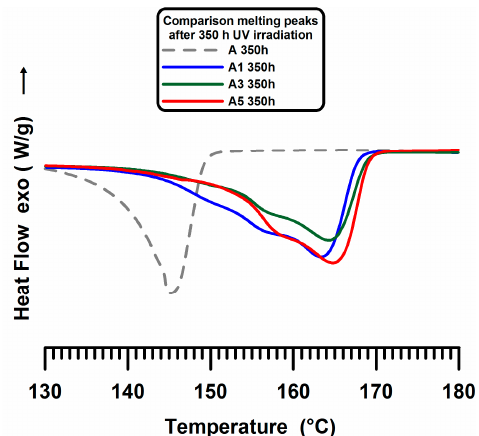
Figure 8. Calorimetric-melting endotherm traces of A, A1, A3 and A5 samples after 350 h of UV irradiation.